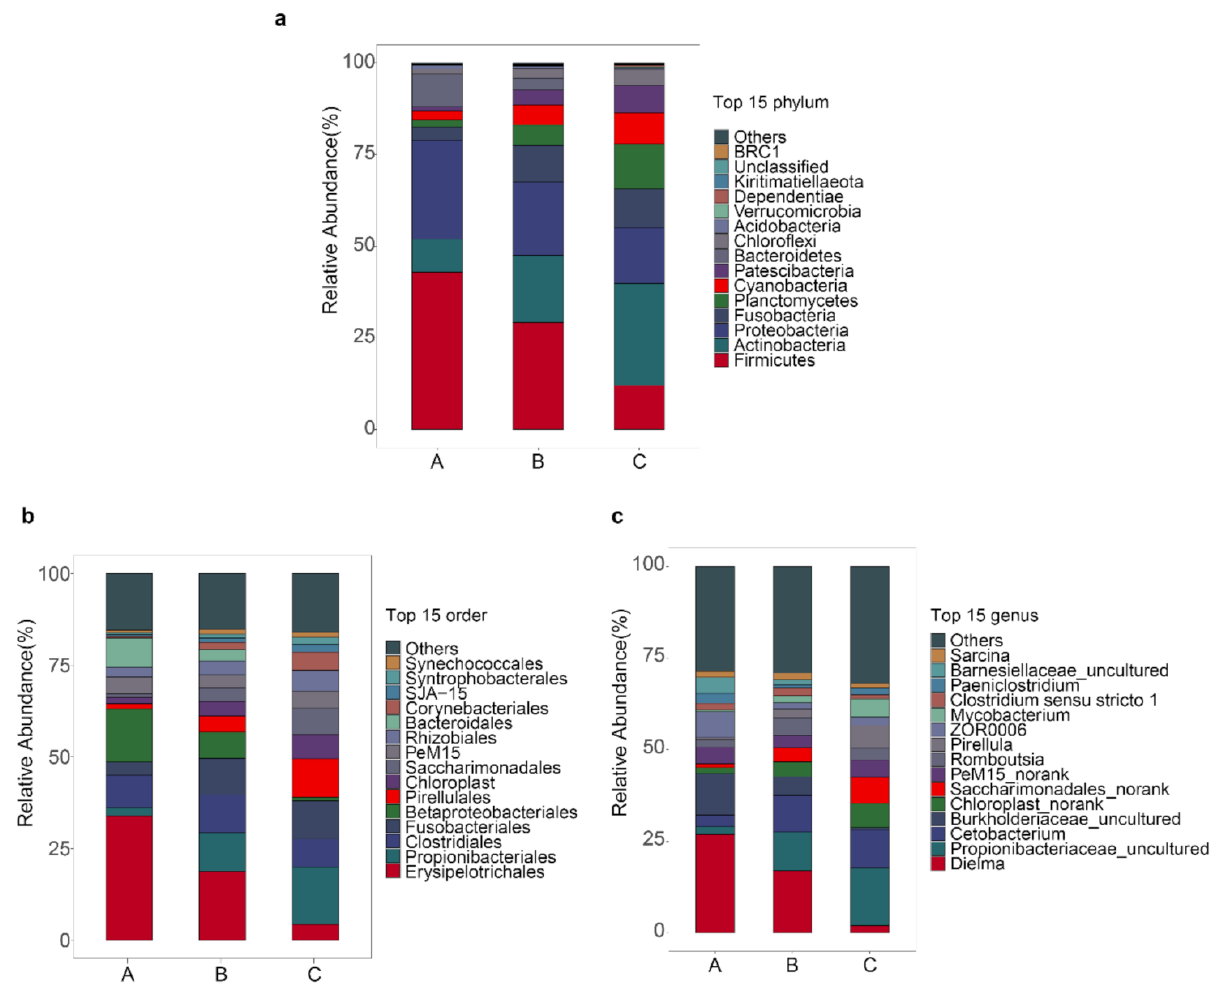
Figure 2. Global composition of bacteria at different taxonomic levels. ( a ) Phyla level ( b ) order level ( c ) genus level. A, nature live food only; B, nature live food + fish feed; C, nature live food + fish feed + lactic acid bacteria. Only the top 15 organisms are